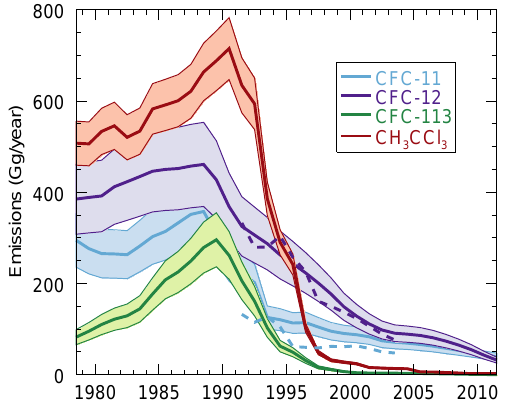
Fig. 3. Emissions estimates for CFC-11, -12, -113 and CH 3 CCl 3 from 1978 to 2011. CFC estimates from 2005 to 2011 are projec- tions (not based on reported data). Dashed lines show independently compiled emissions from UNEP/TEAP (2006). Shaded areas show 1-sigma uncertainties, which are estimated based on the root-mean- square difference between the two